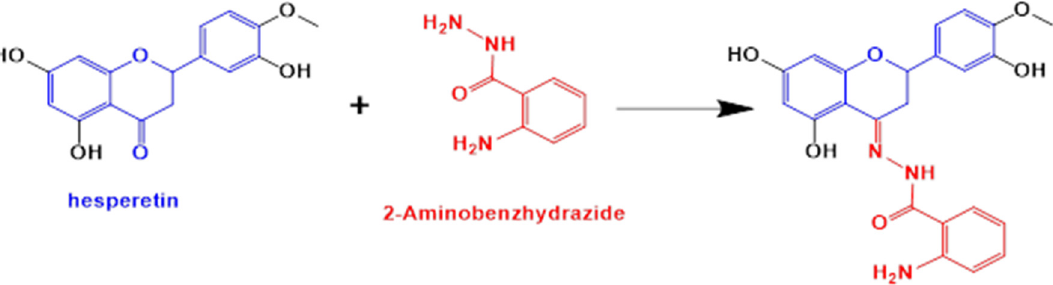
Figure 1. Synthesis of 2-amino-N ′ -(2,3-dihydro-5,7-dihydroxy-2-(3-hydroxy-4-methoxyphenyl)chromen-4-ylidene)benzohydrazide (HABH).